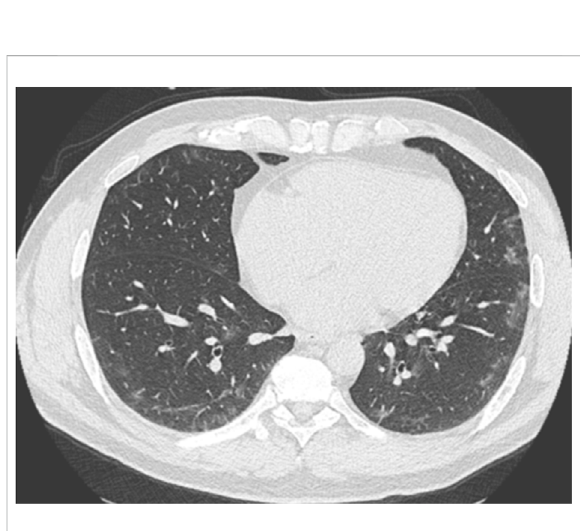
FIGURE 2 AsymptomaticdiverwithachestCTscanperformed1 month after a positive PCR test. A characteristic appearance of very mild COVID-19-related lung involvement with limited bilateral ground glass opacities can be